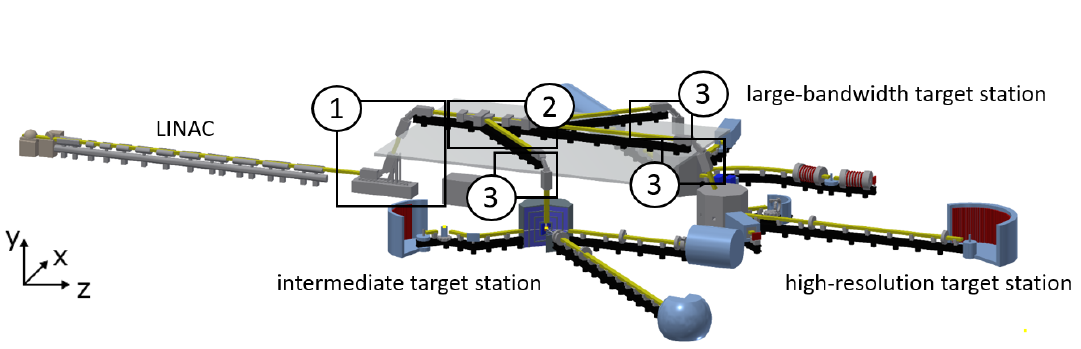
Figure 3. Layout of the HBS facility with three target stations. The neutron production will be driven by a 70 MeV, 100 mA proton LINAC as shown in the left part of the figure. The target stations are classified according to their proton pulse structures. The beam transport from the accelerator to the target station can be subdivided into three segments as shown in the figure. Segment one represents a achromatic system to transport the beam to the top floor. Segment two comprises the Multiplexer unit and segment three uses units from segment one in order to bend the beam towards the target station without dispersion.